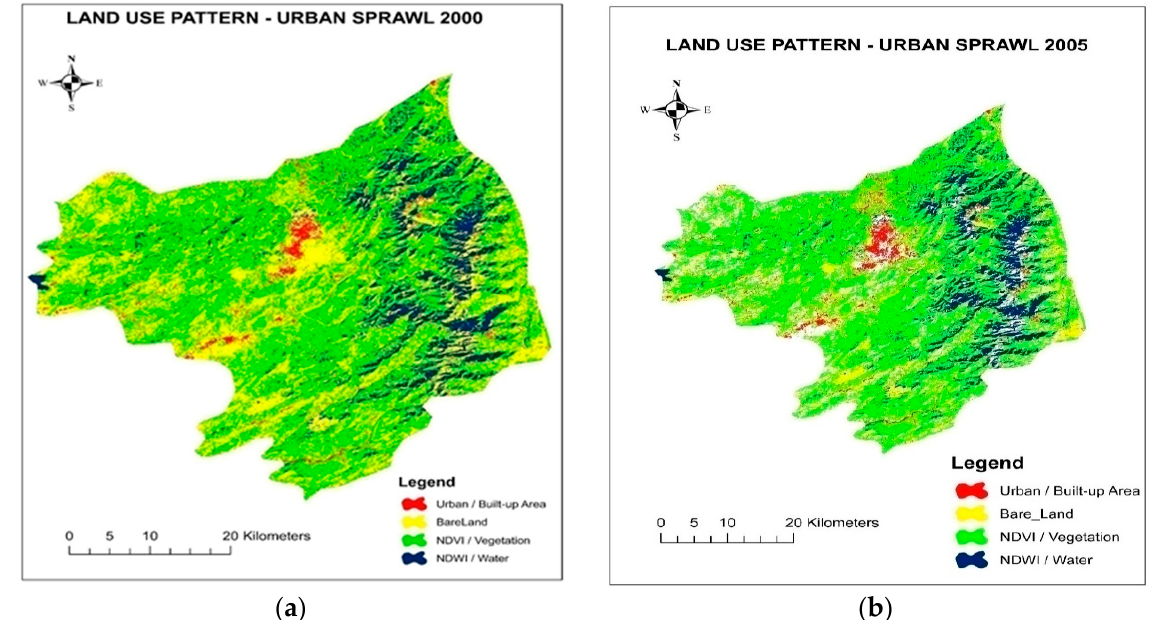
Figure 4. ( a ) Land use pattern—urban sprawl 2000 and ( b ) land use pattern—urban sprawl 2005.